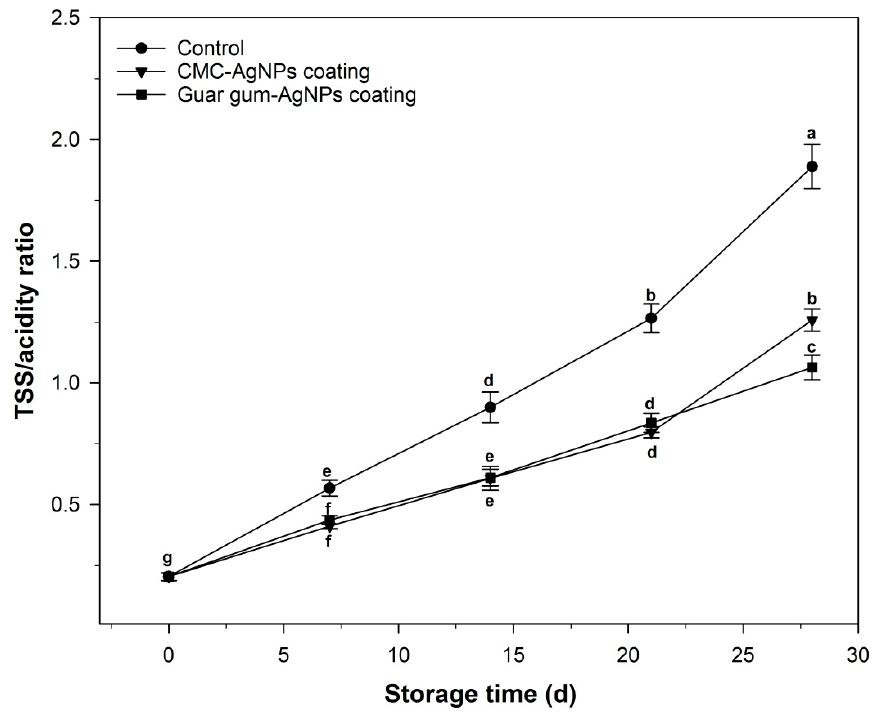
Figure 10. Effect of CMC-AgNP and guar gum-AgNP coatings on TSS/TA ratio of “Seddik” mango fruits stored at 13 °C for 4 weeks. Vertical bars represent the SE of means. Means with the same letter are not significantly different according to Duncan’s multiple range test ( α ≤ 0.05).